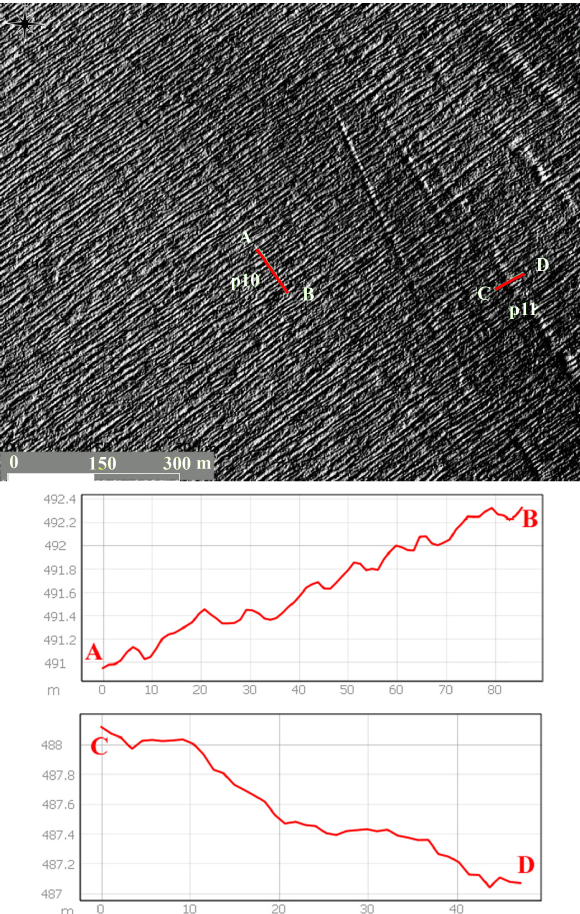
Figure 8. Microtopographic snow/ice features of eolian origin at the site 7: the 1-m gridded hill-shaded map and two cross- sections A–B and C–D. One can see snow/ice microfeatures of eolian origin, as well as several crevasses. For the site location, see Fig.